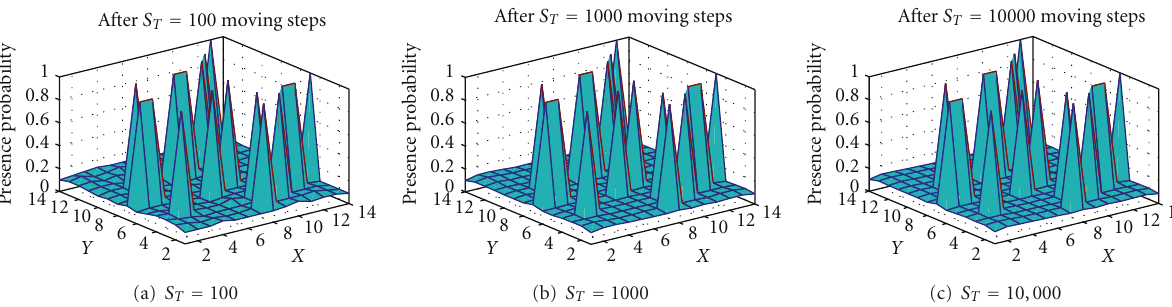
Figure 8: Presence probability matrix with proposed mobility protocol, N = 40, λ m = 0 . 5, and v max = 10m/s (a) after moving steps S T = 100, (b) after moving steps S T = 1000, and (c) after moving steps S T = 10,000.